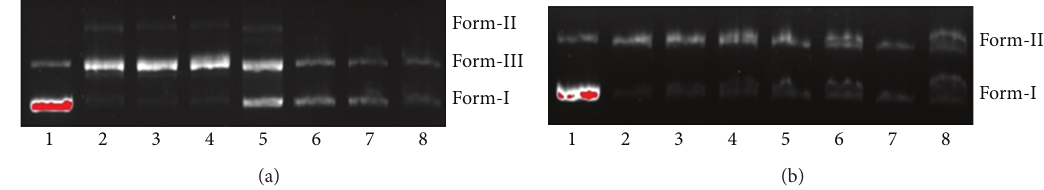
Figure 6: Agarose gel electrophoresis patterns for the oxidative cleavage of pBR 322 DNA by 1 and 2(a) and photolytic cleavage of pBR 322 DNA by 1 and 2(b). (a) Lane 1, DNA control; Lane 2, DNA+ 1 (40 𝜇 M) + H 2 O 2 (1mM); Lane 3, DNA+ 1 (80 𝜇 M) + H 2 O 2 (1mM); Lane 4, DNA+ 1 (120 𝜇 M) + H 2 O 2 (1mM); Lane 5, DNA + H 2 O 2 (1mM) + DMSO (1mM). Lane 6, DNA+ 2 (40 𝜇 M) + H 2 O 2 (1mM); Lane 7, DNA+